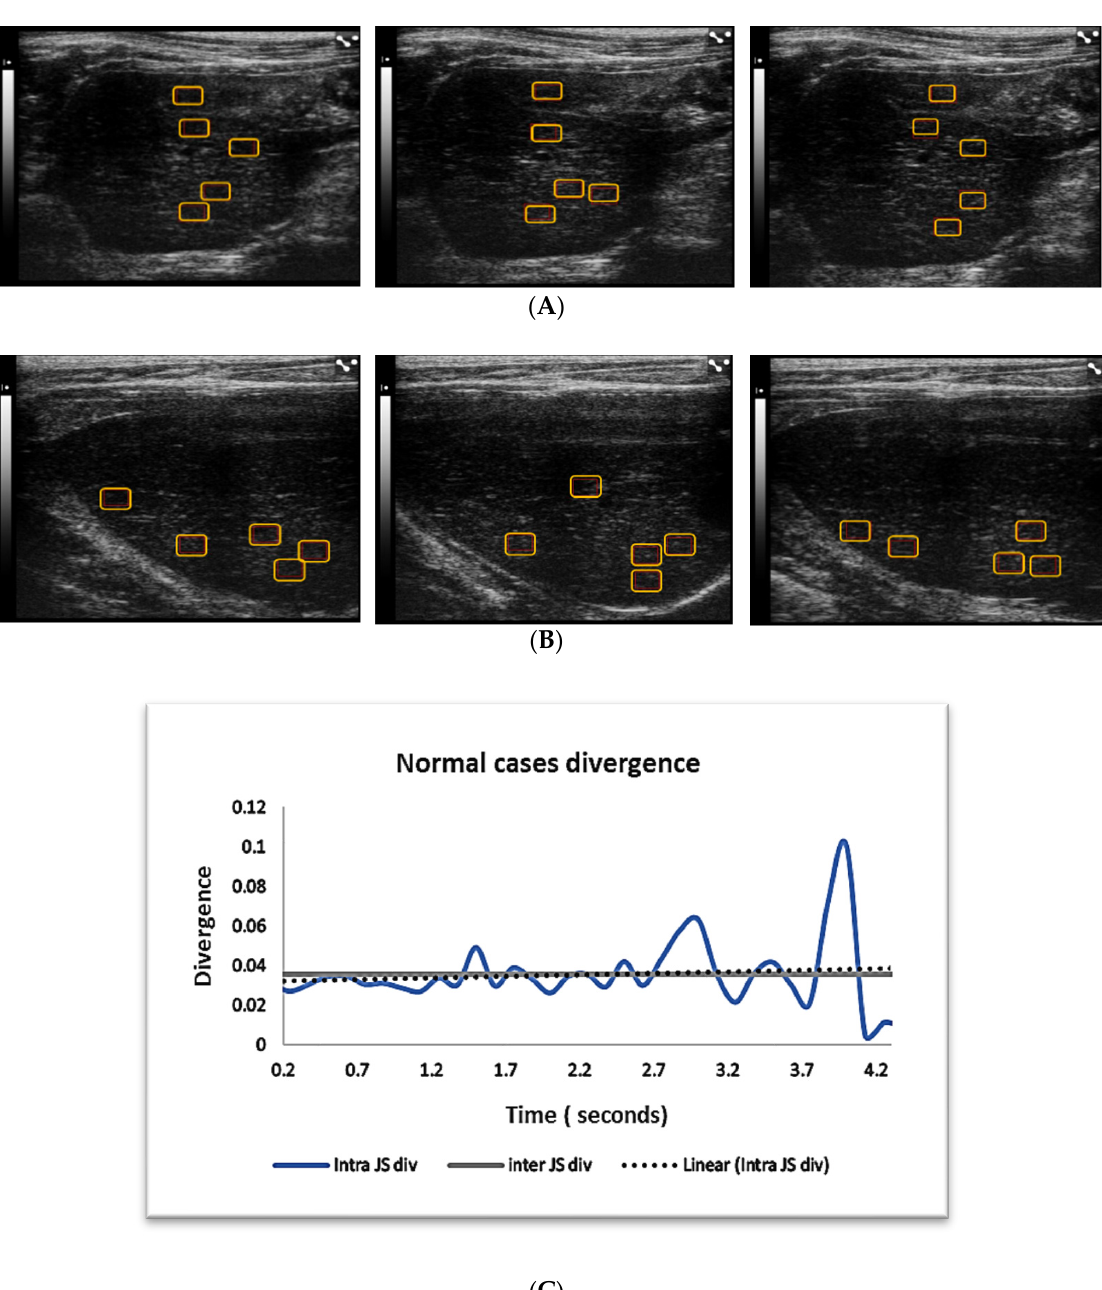
Figure 3. Panels ( A , B ) show examples of B-mode ultrasound liver images taken from two normal